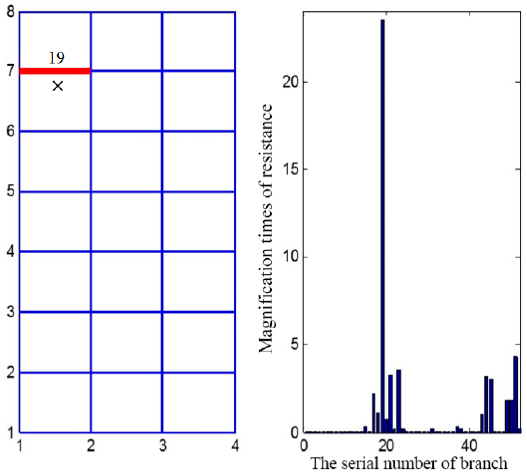
Figure 13. The results of the single branch fault case with the galvanized steel strap network.